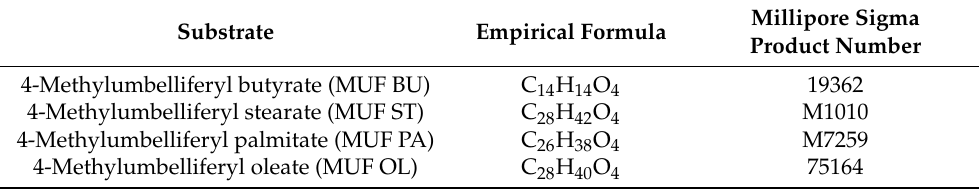
Table 1. List of MUF substrates that have been used to assay esterase activity in the ocean.